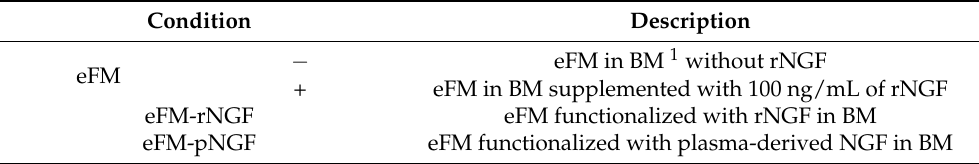
Table 2. Experimental conditions used in the cell biology assays. Condition Description